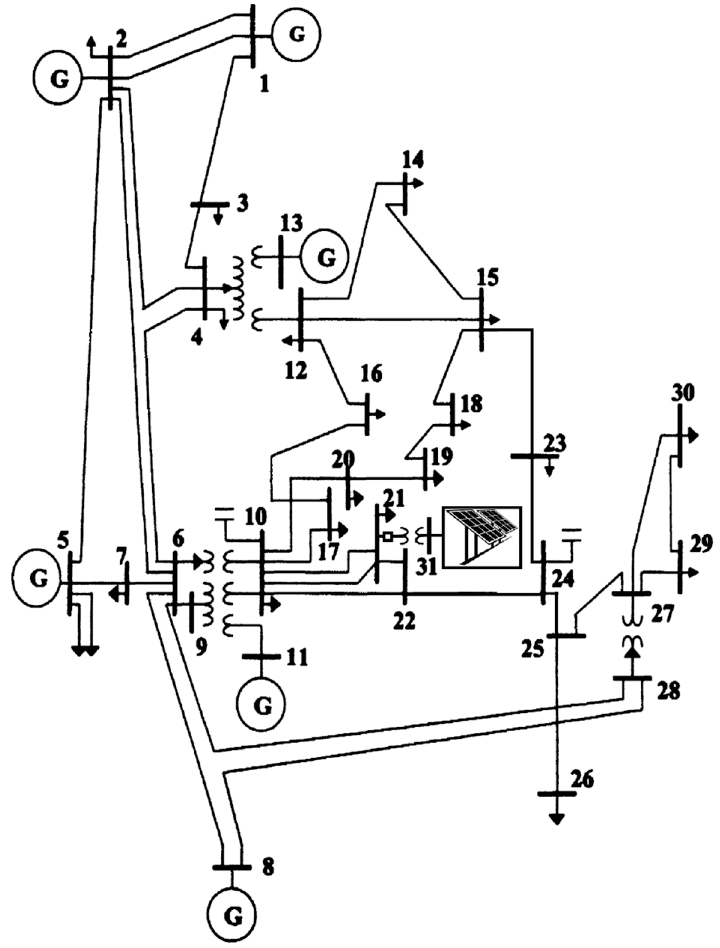
Figure 5. IEEE 30-Bus modified single line diagram.